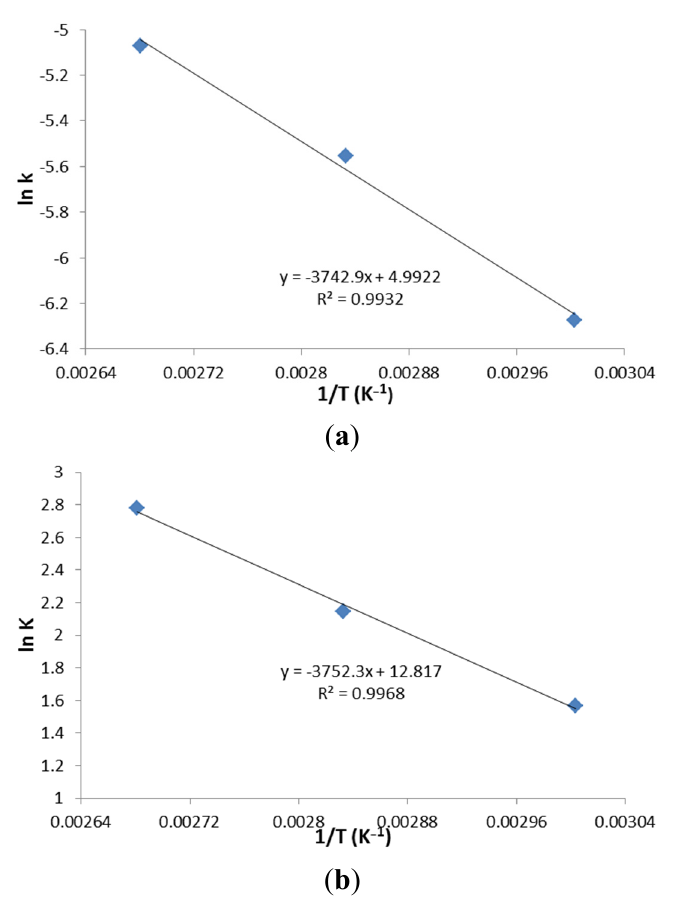
Figure 4. Plot of linear form for activation energy and Gibbs free energy at catalyst loading of 2 wt %: ( a ) Linear form of Arrhenius equation; ( b ) Linear form of Van’t